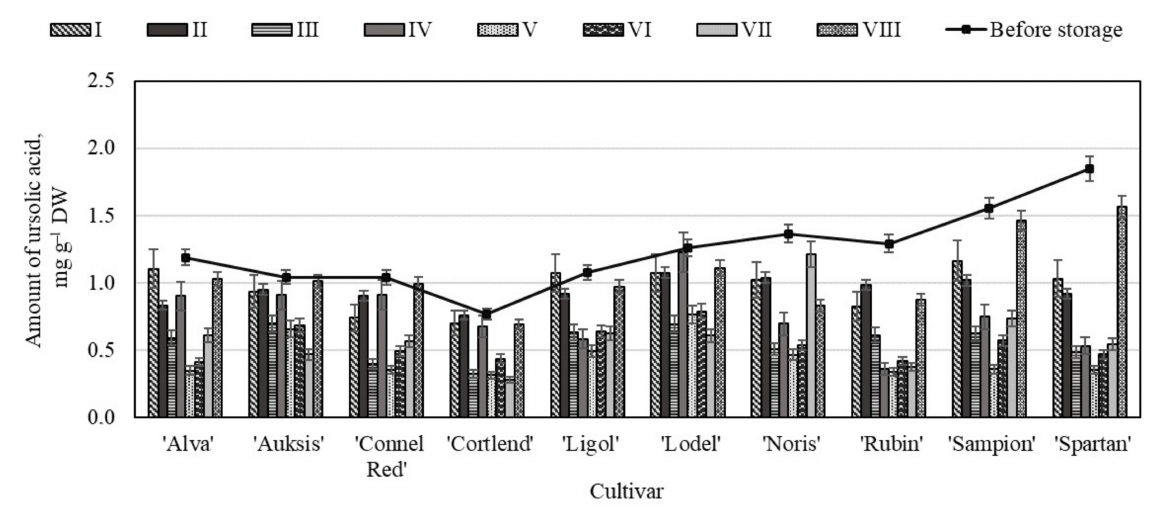
Figure 3. Changes in amount of ursolic acid in the whole apple samples before and after storage in